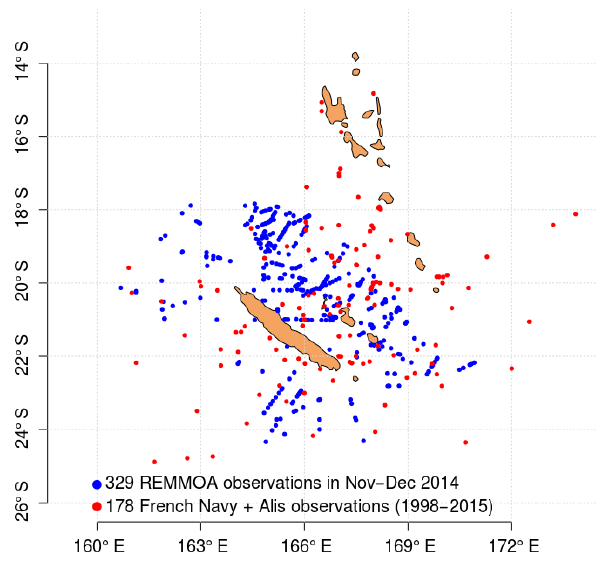
Figure 1. Map of in situ (visual) observations of Trichodesmium mats gathered in the studied